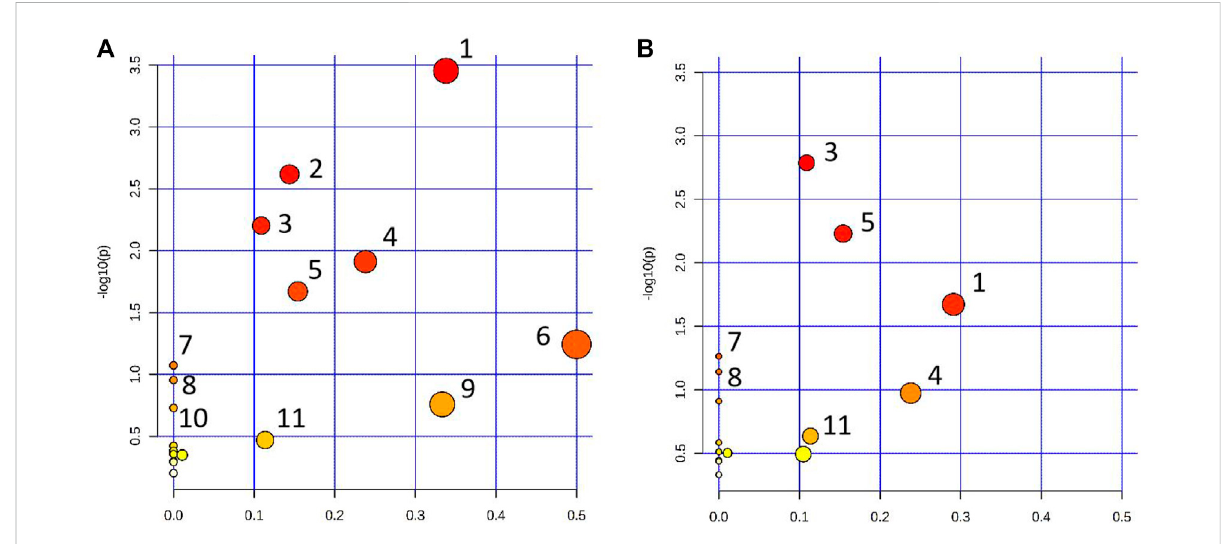
FIGURE 11 Metabolic pathway analysis results. (A) Pathway analysis of rat urine samples in the CWT treatment group; (B) Pathway analysis of rat urine samples in the D group (1: Lysine degradation; 2: Tryptophan metabolism; 3: Folate biosynthesis; 4: Phenylalanine metabolism; 5: Tyrosine metabolism; 6: Ribo fl avin metabolism; 7: Nitrogen metabolism; 8: Valine, leucine and isoleucine biosynthesis; 9: alpha-Linolenic acid metabolism; 10: Arginine biosynthesis; 11: Alanine, aspartate, and glutamate metabolism).